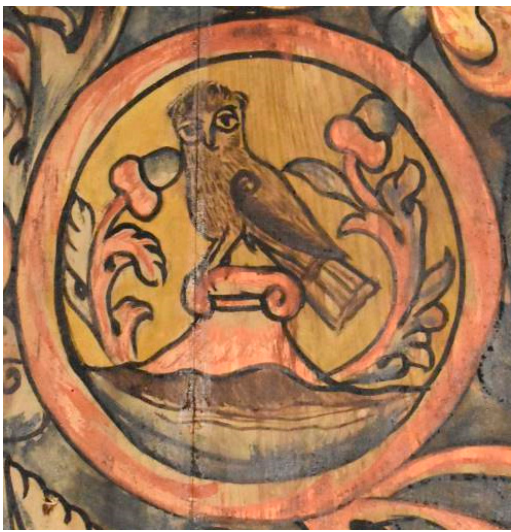
Figure 1. An owl, painting on a wooden panel. Unterlimpurg, Synagogue, 1738/9. Schwäbish Hall, Hälisch Fränkisches Museum. Photograph: Zvi Orgad, 2017. Used by permission.